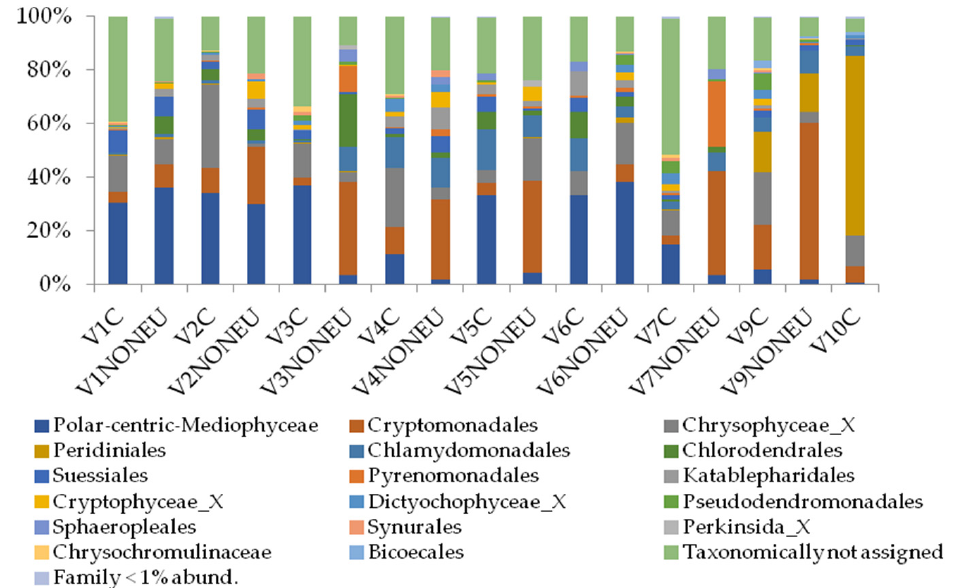
Figure 7. Relative abundance shares of phytoplankton family ranks (expressed in percentages) in the composite (C) and aphotic zone (NONEU) samples of sampling stations (V1 to V10, excluding station V8) in Lake Visovac during August 2018 according to the molecular (eDNA) approach.